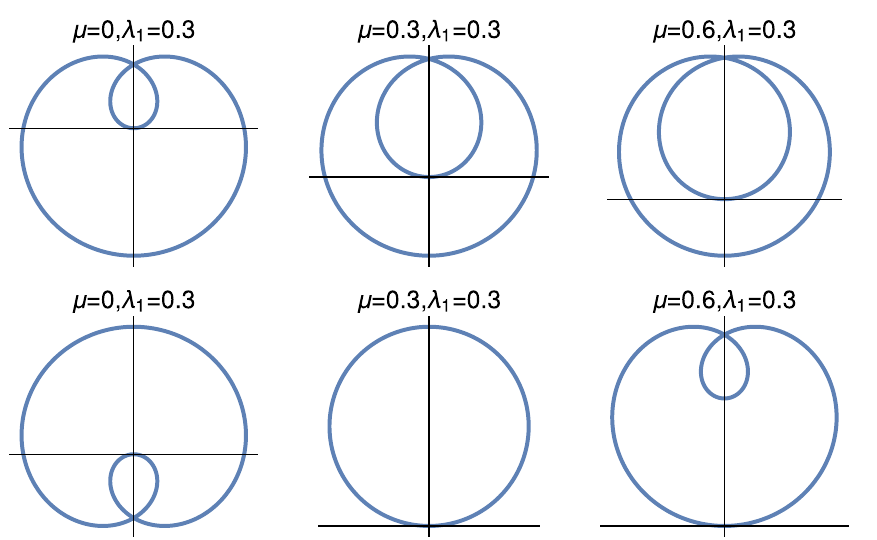
Figure 5. Parametric plot of the χ ˆ k ( ) . The upper panel is for the λ 2 = μ + λ 1 and the lower panel is for λ 2 = μ − λ 1